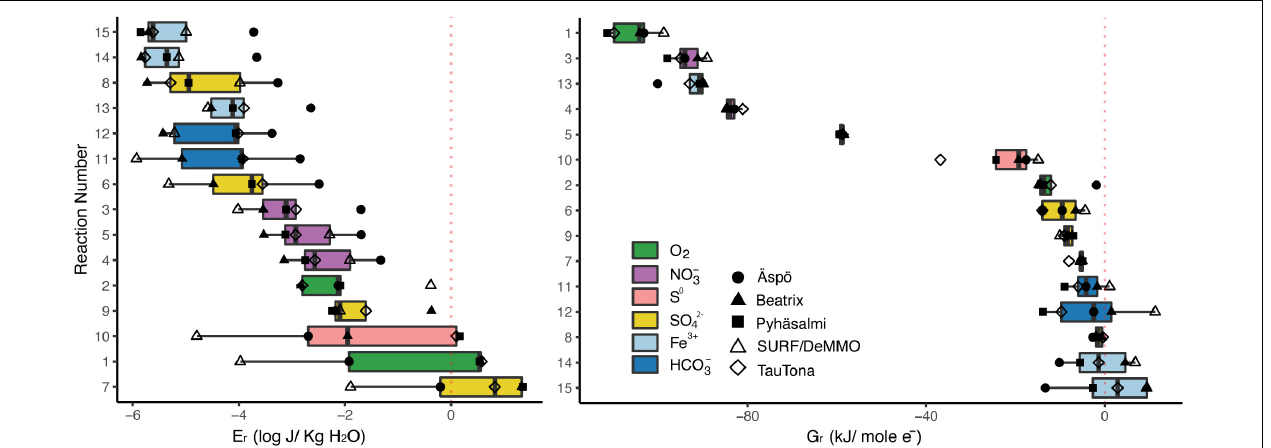
FIGURE 2 | Estimated energetic landscape of the fifteen reactions presented in Table 1 for five selected deep fracture fluids, as accessed in subsurface laboratories. Calculated energy densities are presented at left, and (cid:49) G r estimates are at right (normalized as kJ/mol and the number of electrons involved in the reaction). Electron acceptors for each reaction are highlighted. Fracture fluid geochemistry data are from: Aspö - Hallbeck and Pedersen (2008), sample “KJ0052F01/2006-03-23/43.70-43.90 m;” Beatrix mine – Lin et al. (2006b), sample “BE325;” Pyhäsalmi – Miettinen et al. (2015), sample “R-2247;” SURF – Osburn et al. (2014), sample “‘Manifold B;” TauTona – Magnabosco et al. (2016), sample “TT107.” Methods for estimated values may be found in Supplementary Material